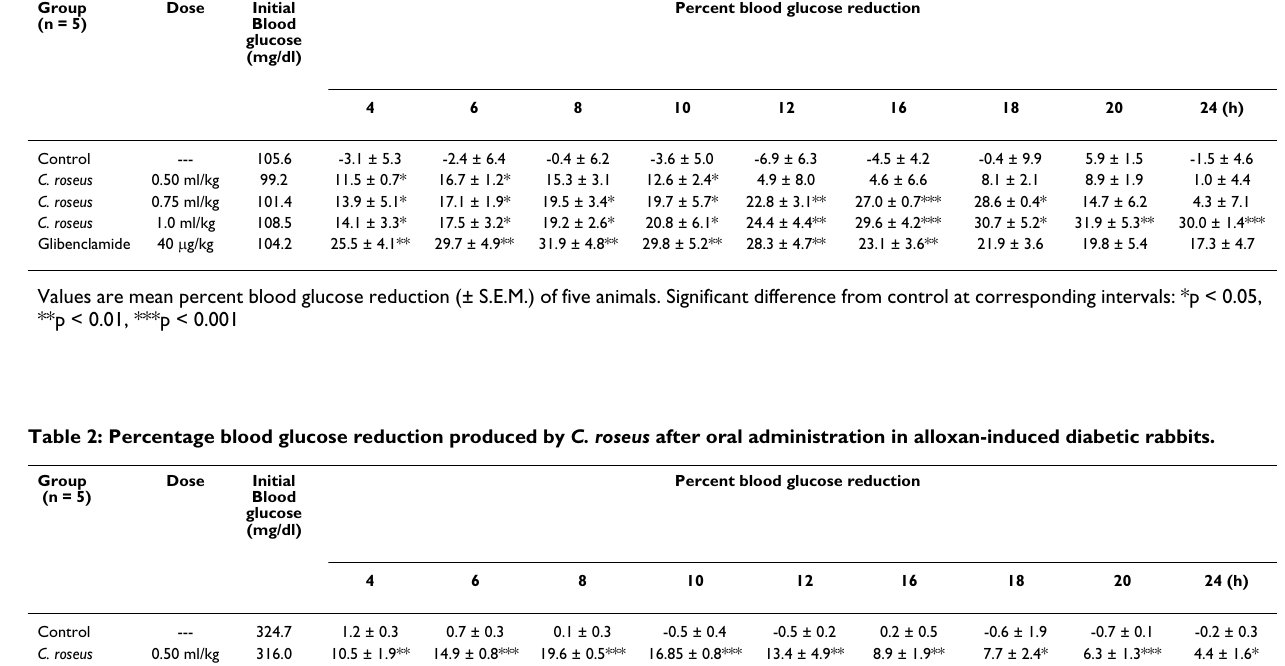
Table 1: Percentage blood glucose reduction produced by C. roseus after oral administration in normal rabbits. Group Dose (n = 5)